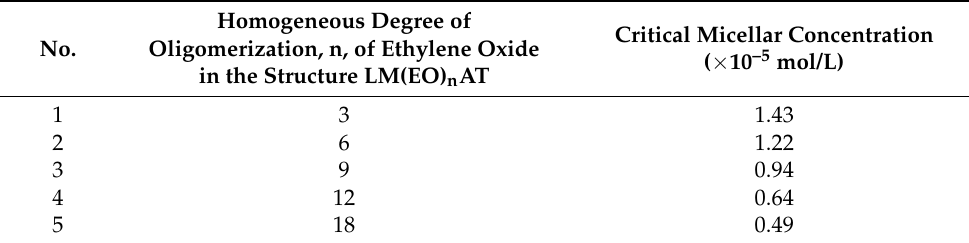
Table 5. Critical micellar concentration of homogeneous tertiary N , N -dimethyl- N - β